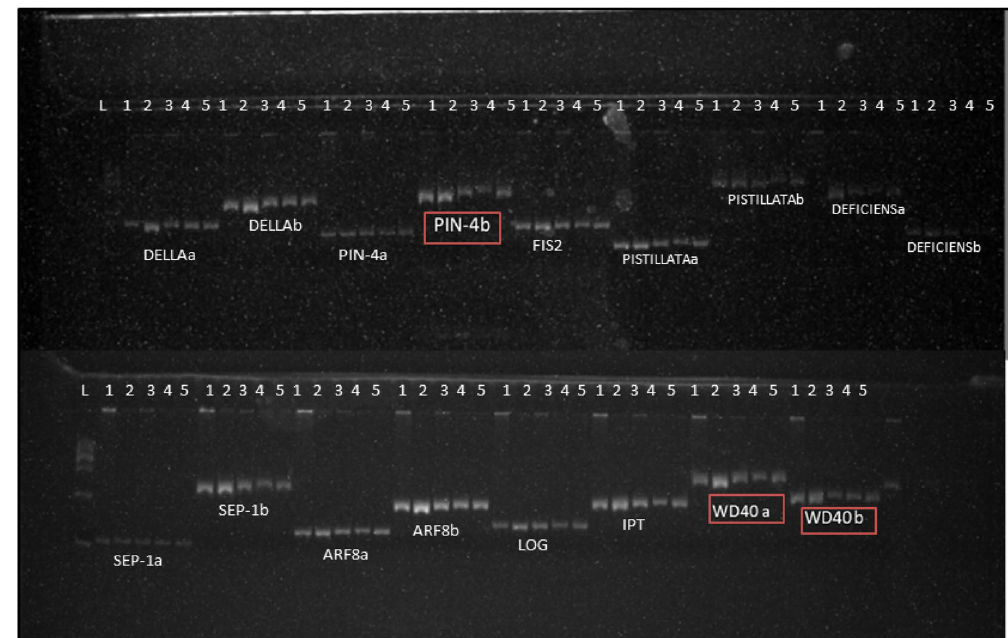
Figure 9. PAGE image showing parental polymorphism (L: 100 bp ladder; 1: Punjab Naveen; 2: Gy-14; 3: AVCU1303; 4: Punjab Kheera-1; and 5: PBRK5). Polymorphic markers are shown in red